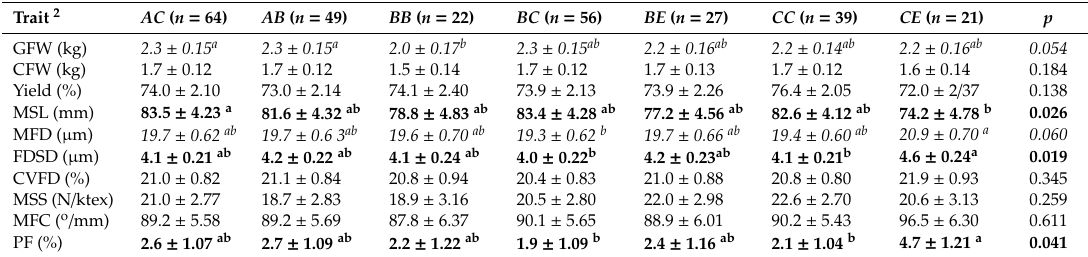
Table 3. The e ff ect of KRTAP21-2 genotype on various wool traits (Mean ± SE) 1 . Trait